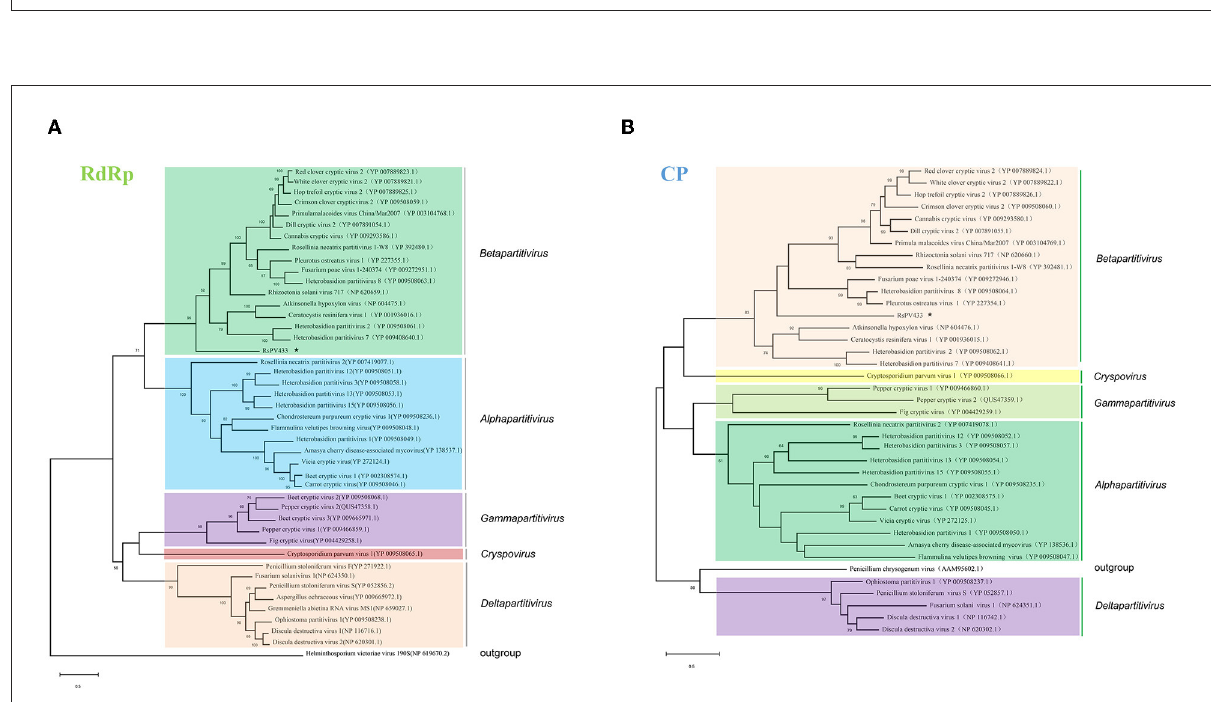
FIGURE2 Phylogenetic analysis of RsPV433. Phylogenetic trees were generated based on the amino acid sequences of the RdRp and CP of RsPV433. (A) All viruses listed in NCBI virus taxonomy of Partitiviridae were chosed and their RdRp were selected and clustered in this phylogenetic tree, result suggested that RsPV433 is probably belongs to the Betapartitivirius of Parititiviridae . (B) Phylogenetic tree of viral coat protein encoded by partitiviruses. RsPV433 encoded coat protein was clustered in the Betapartitivirus